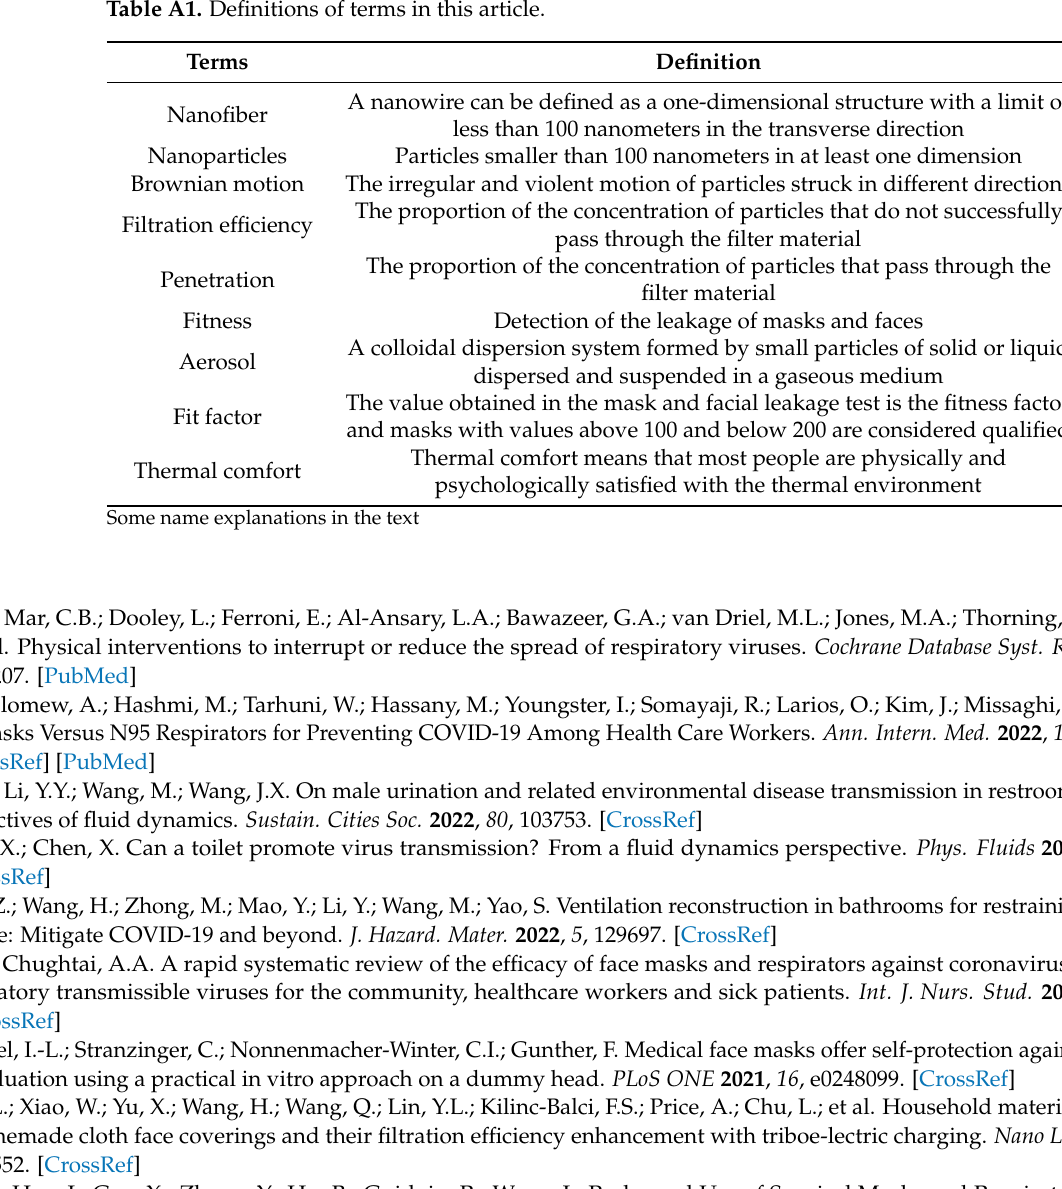
Table A1. Definitions of terms in this